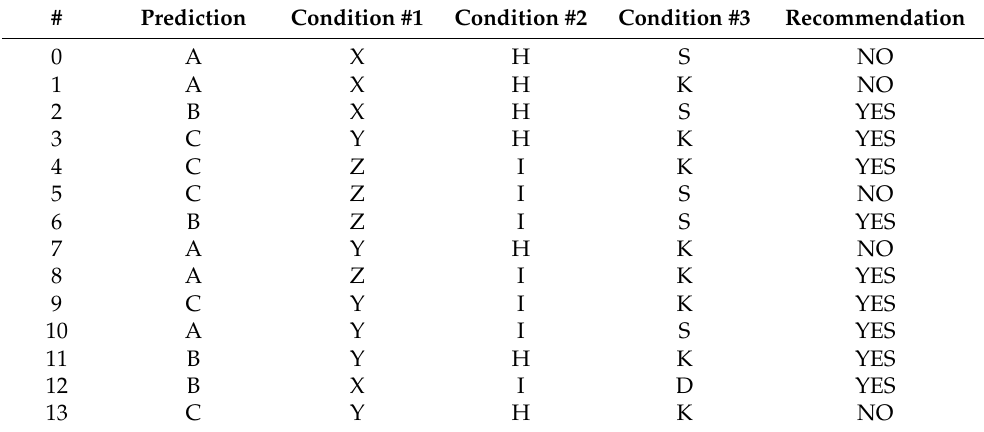
Table 1. Our training